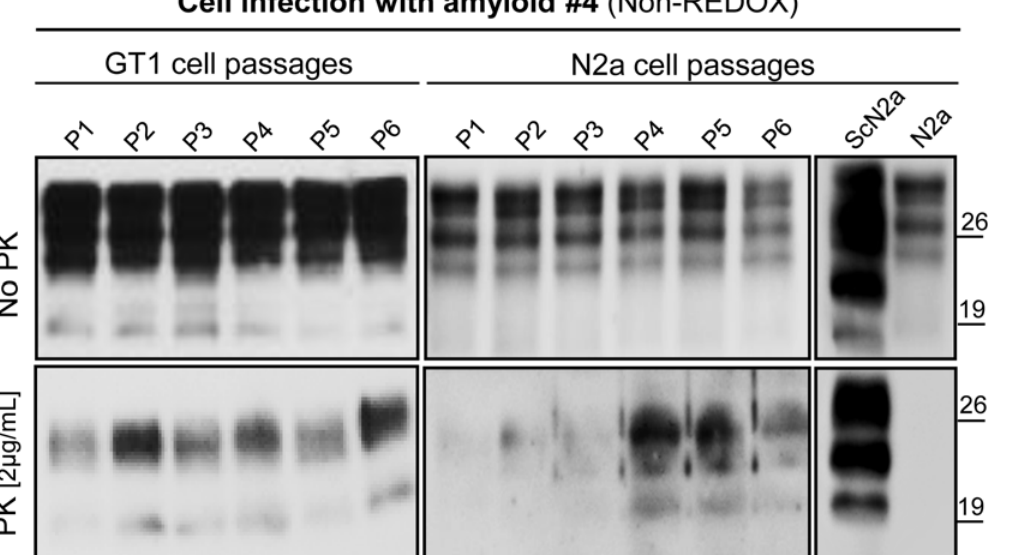
Fig 6. PK digestion assay of GT1 and N2a cells collected at different passages after infection with amyloid fibrils. Western blotting of GT1 and N2a cell lines infected with PrP amyloid #4 was observed throughout, from first passage (P1) to sixth passage (P6) and after treatment with proteinase K at ratio 1:500 (w/w). Western blot was performed using Fab D18 monoclonal antibody (1 μ g/mL). Blots were developed with the enhanced chemiluminescent system (ECL, Amersham Biosciences) and visualized on Hyperfilm (Amersham Biosciences).